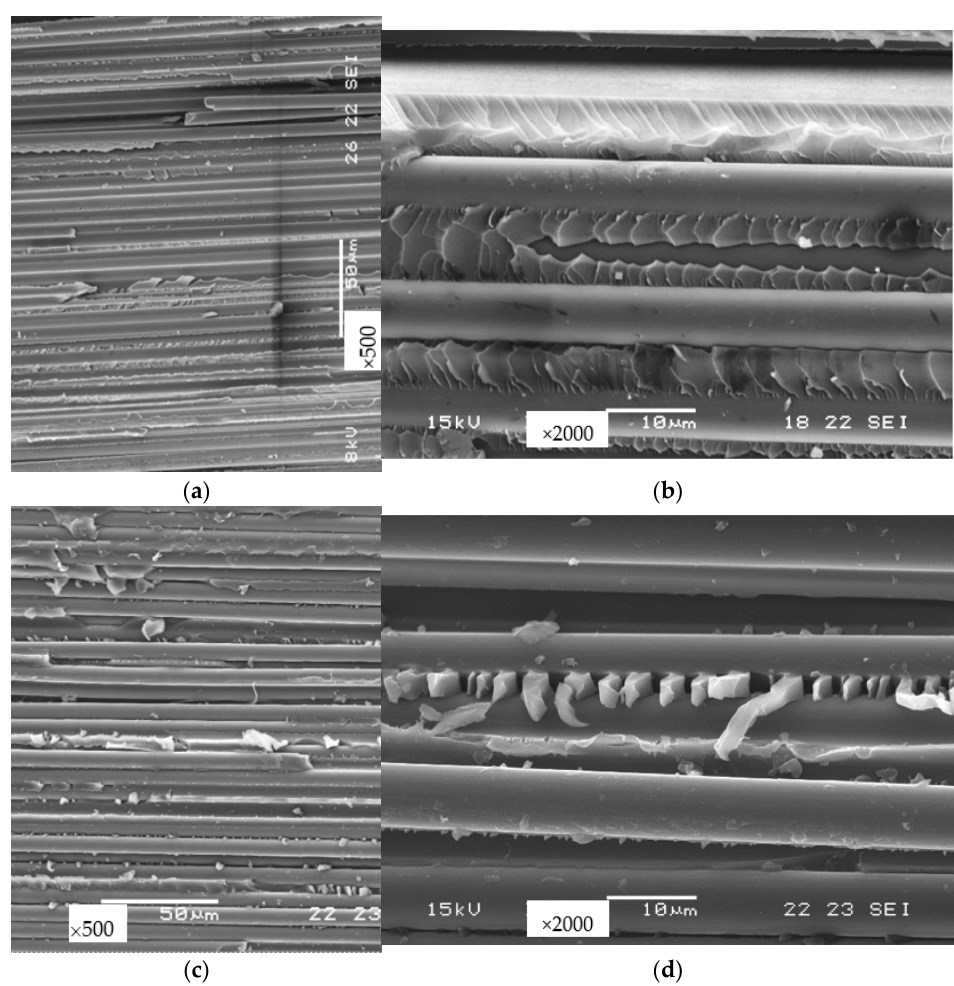
Figure 9. Sites of delamination cracks in DVN coupons for various orientations; ( a ) 0°; ( b ) 90°.